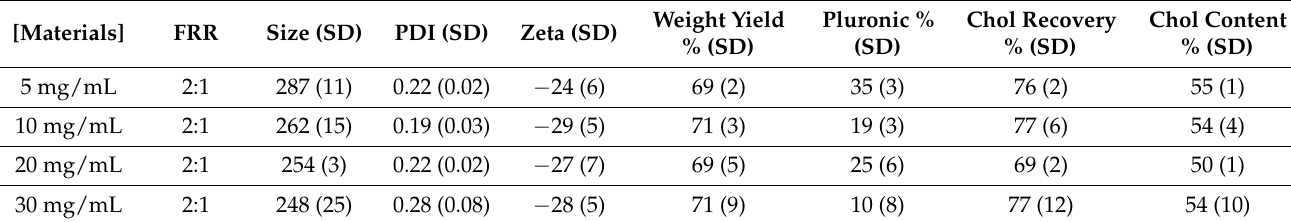
Table 3. Physico-chemical characterization of H-NMeds obtained with the microfluidic device varying the initial concentra- tion of core materials in the organic phase. Standard Deviation (SD) is reported in